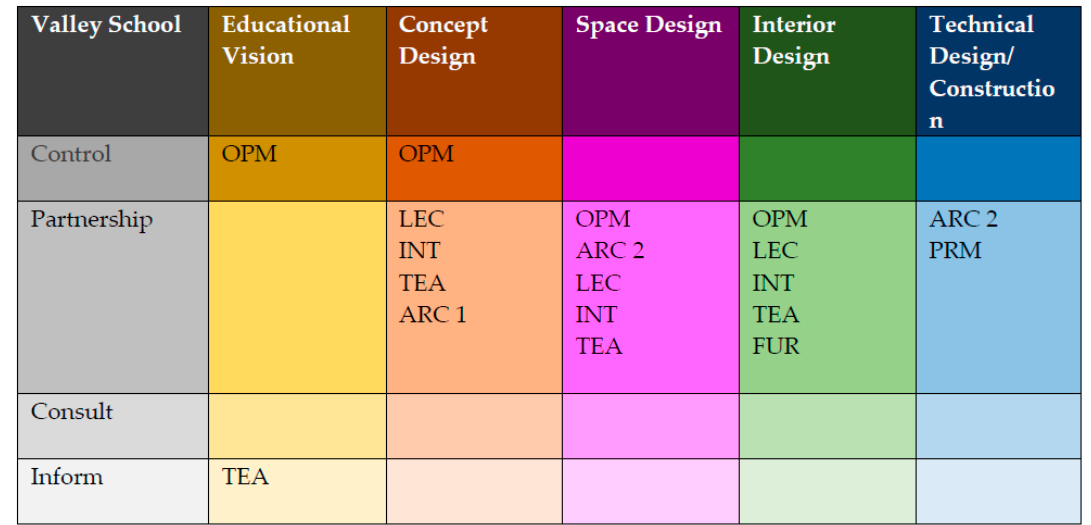
Figure 6. The ECSIT model plotting stakeholder influence in different phases of the design and building process at Valley school. ARC: architect; FUR: furniture company representative; INT: interior designer; LEC: learning environment consultant; PRM: property manager; and TEA: teachers. OPM: Operations Manager